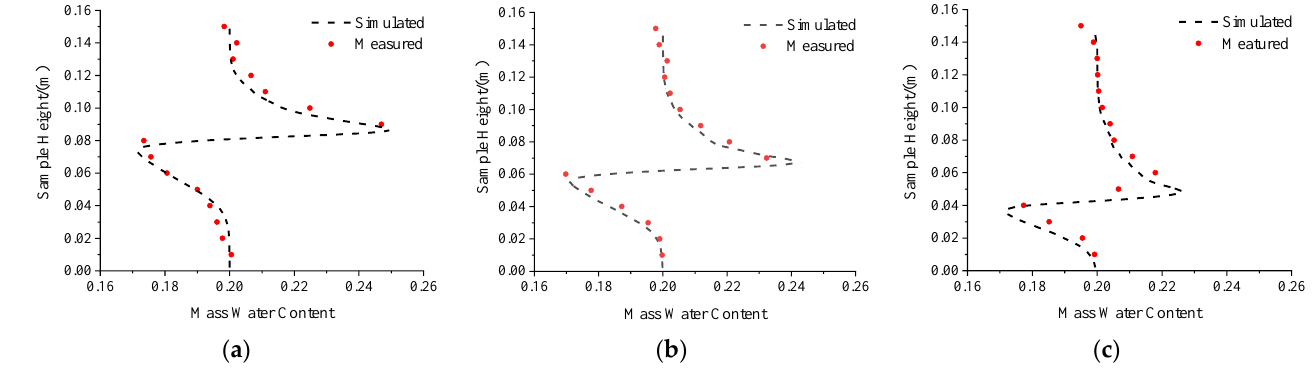
Figure 9. Distribution of water content along the height of the sample at different cold end temperatures: ( a ) cold end temperature of −5 °C; ( b ) cold end temperature of −7 °C; ( c ) cold end temperature of −10 °C.